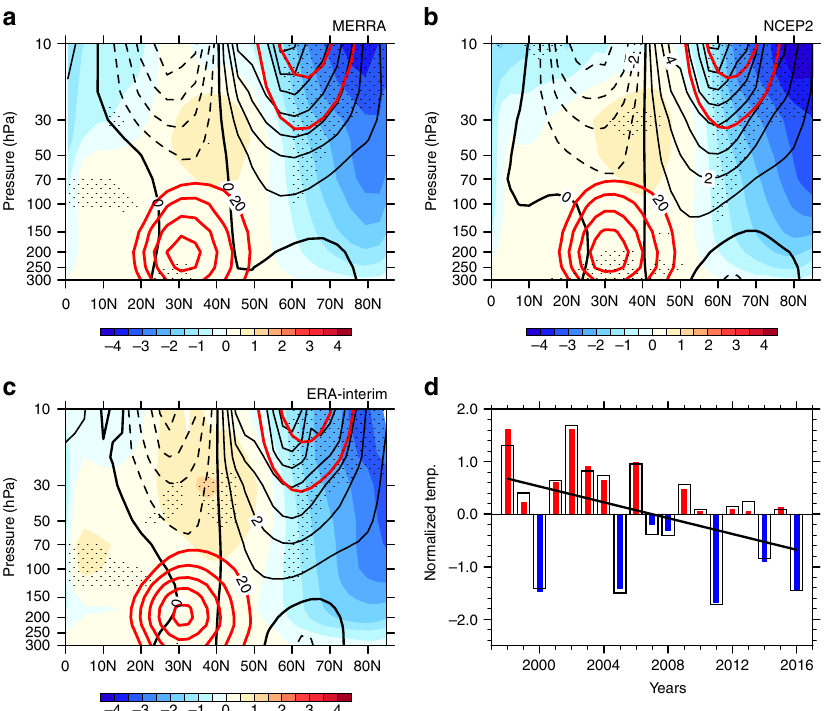
Fig. 1 Temperature and zonal winds trends in the Arctic stratosphere. Temperature (shading, units: K decade − 1 ) and zonal wind (black contours; interval 1 m s − 1 decade − 1 ) trends during 1997/98 – 2015/16 for December – January – February derived from MERRA ( a ), NCEP2 ( b ), and ERA-Interim ( c ). Climatological zonal winds >20 m s − 1 are shown with thick red contours at a contour interval of 5 m s − 1 . Areas where the temperature trends are signi fi cant at/above the 95% level are stippled. The normalized time series of stratospheric temperature averaged over 65°N – 80°N from 50 up to 10 hPa from MERRA (broad open bars) and NCEP2 (narrow fi lled bars) are shown in d . The straight black line indicates the linear trend in the normalized stratospheric polar temperature using